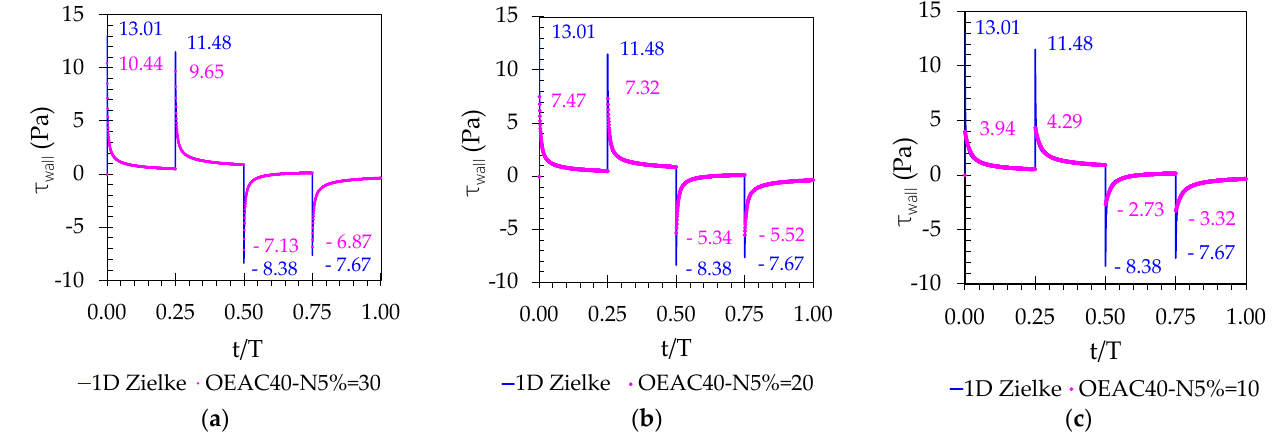
Figure 8. Wall shear stress obtained for OEAC meshes and for the Zielke’s 1D model: ( a ) OEAC40 N 5% = 30; ( b ) OEAC40 N 5% = 20; ( c ) OEAC40 N 5% = 10.